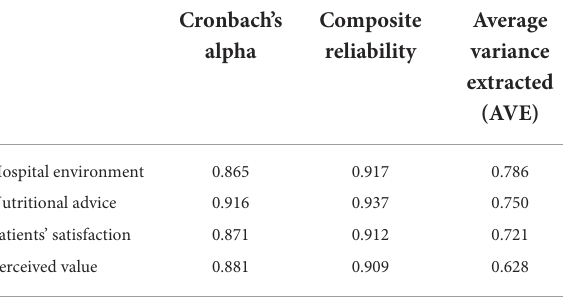
TABLE 1 Construct validity and